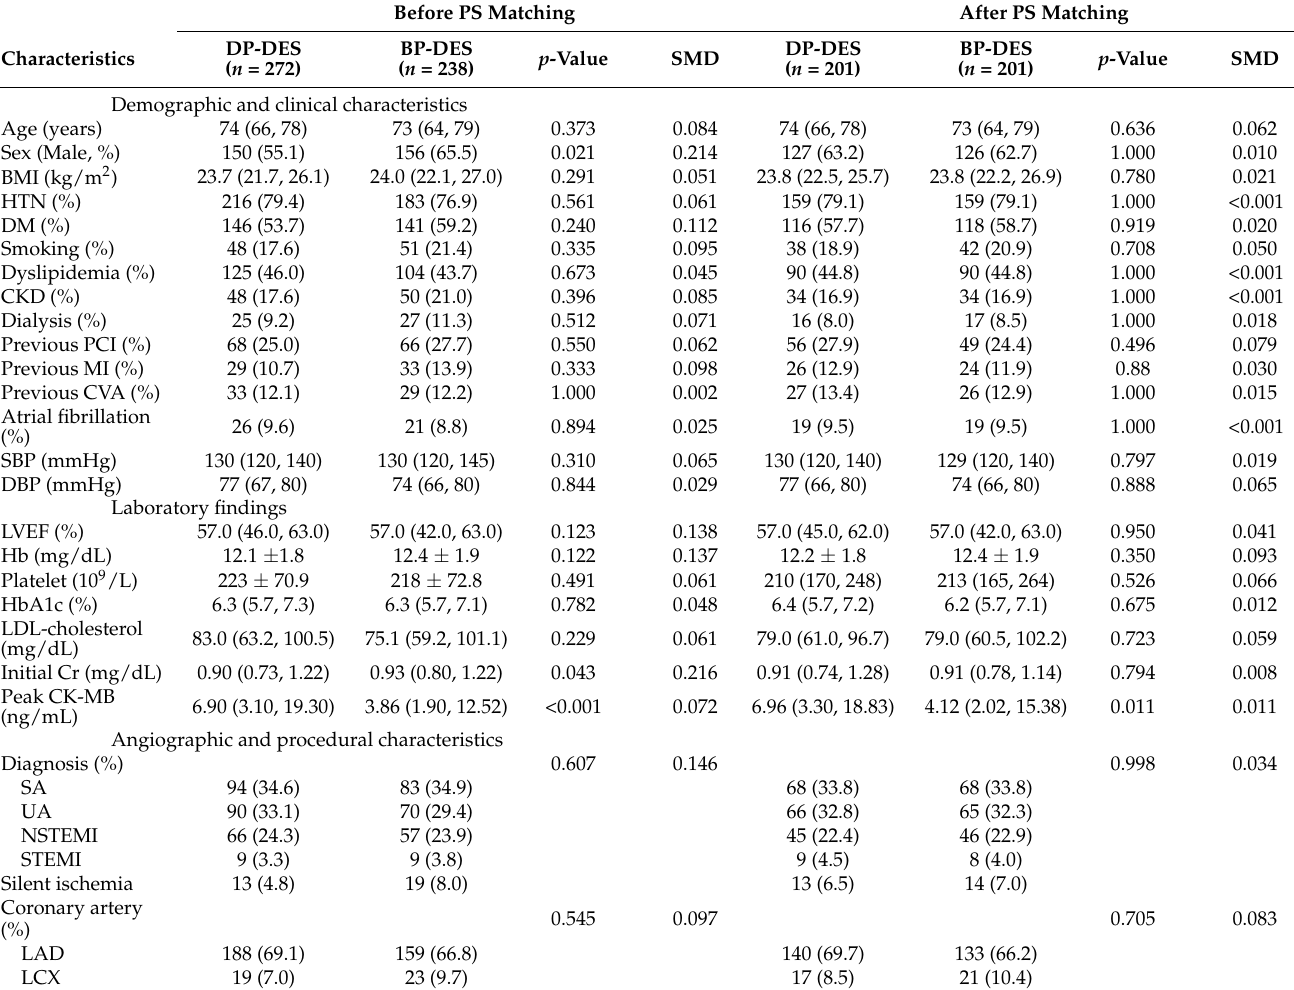
Table 1. Clinical, laboratory, and angiographic characteristics according to stent polymer composition. Before PS